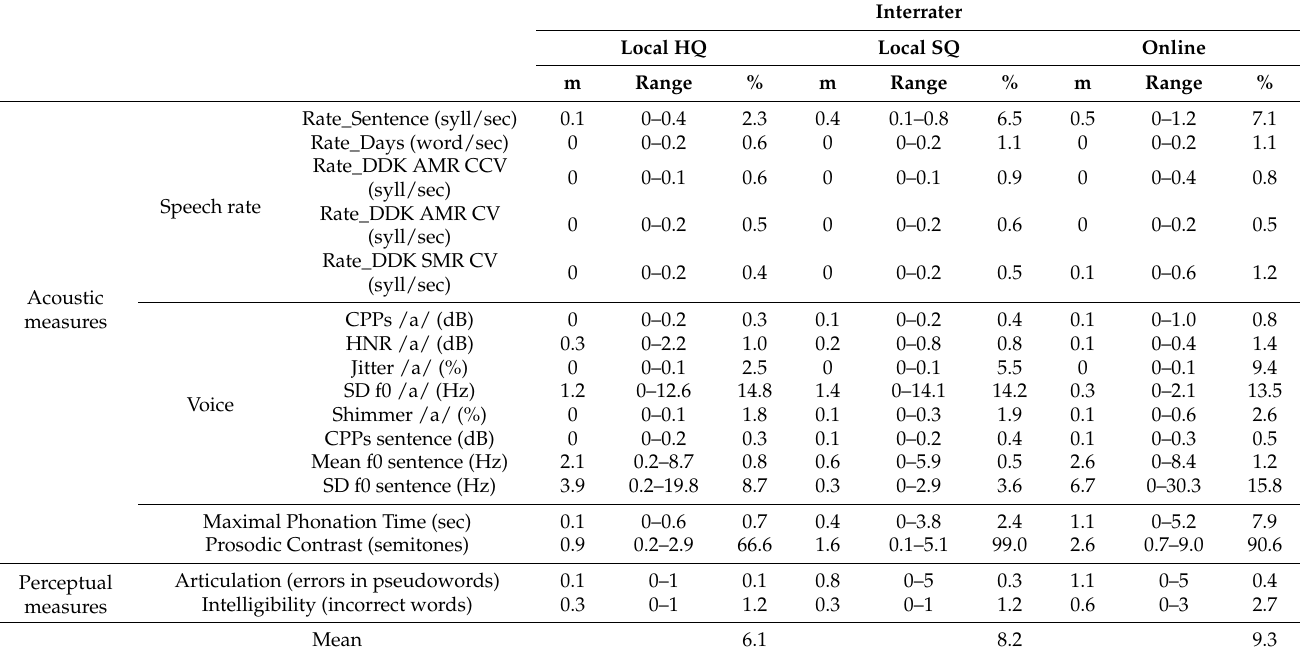
Table 4. Mean raw differences (units in brackets), range of raw differences and mean ratio of divergence (%) between raters in each recording